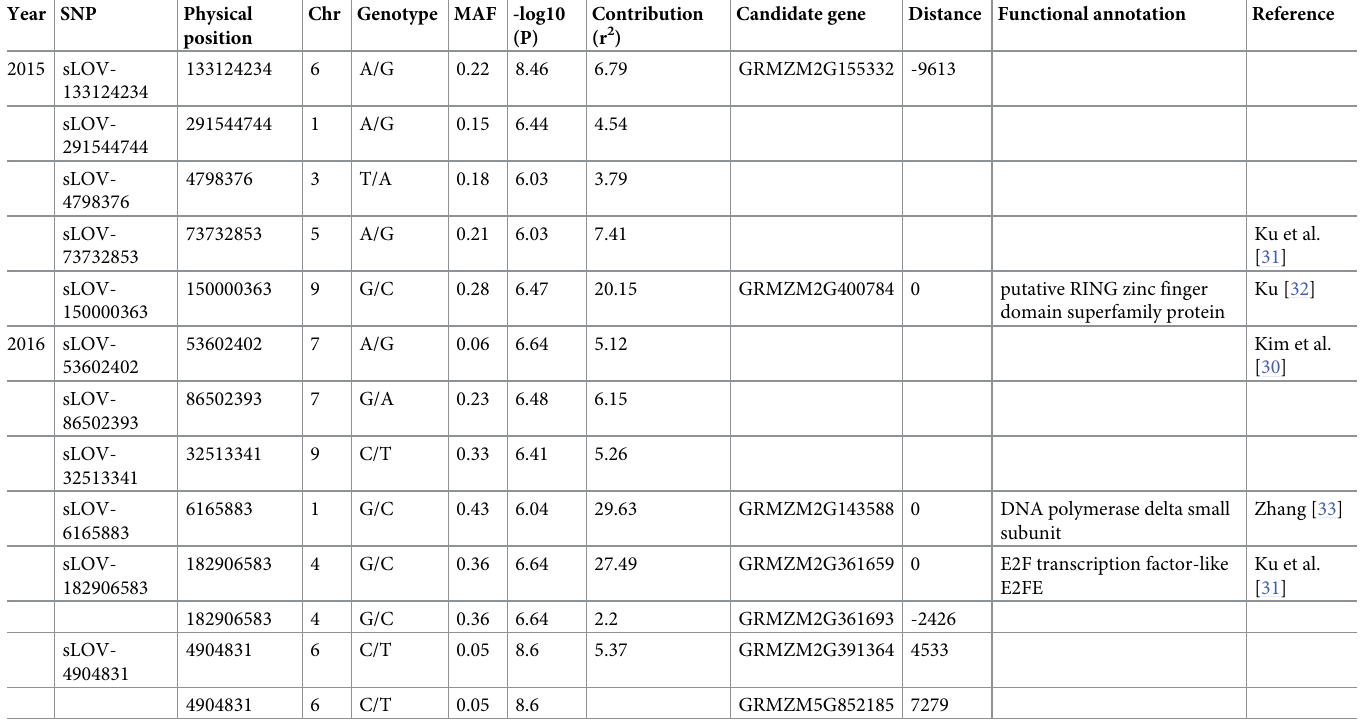
Table 2. Significant SNPs and candidate genes associated with leaf orientation value between 2015 and 2016.